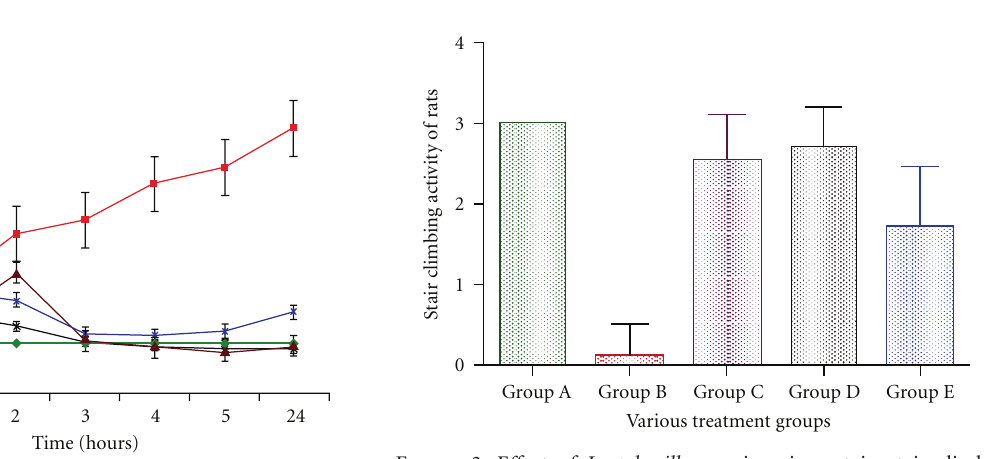
Figure 2: E ff ect of Lactobacillus on impairment in stair climb- ing activity score associated carrageenan-induced inflammation. Edema was induced by injecting 0.1 mL of 1% solution of carrageenan into subplantar surface of right-hind paw. The drugs were administered subcutaneously 30 minutes before injecting inflammagen. Stair climbing activity was observed at the time of peak inflammation (4 hours for carrageenan). Data are expressed as mean ± standard error of seven rats per group. Group A: carrageenan control; Group B: control; Group C: L. casei fed; Group D: L. acidophilus ; Group E: positive control. Table 1: E ff ect of oral administration of L. casei and L. acidophilus on cytokines expression